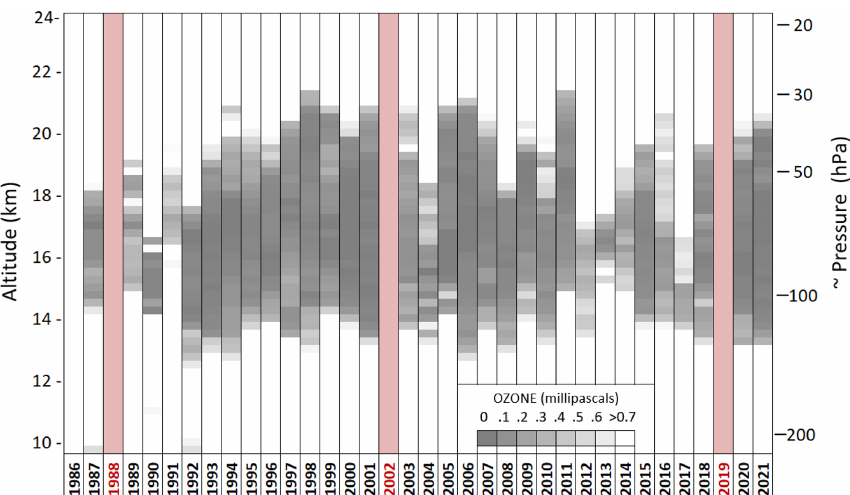
Figure 8. The South Pole 10–24km curtain plots highlighting the lowest observed ozone partial pressure of 0 to 0.7mPa represented by the dark to light gray shading during the yearly ozone hole minimum period from 24 September to 15 October. All values greater than 0.7mPa are excluded from the scale shown.